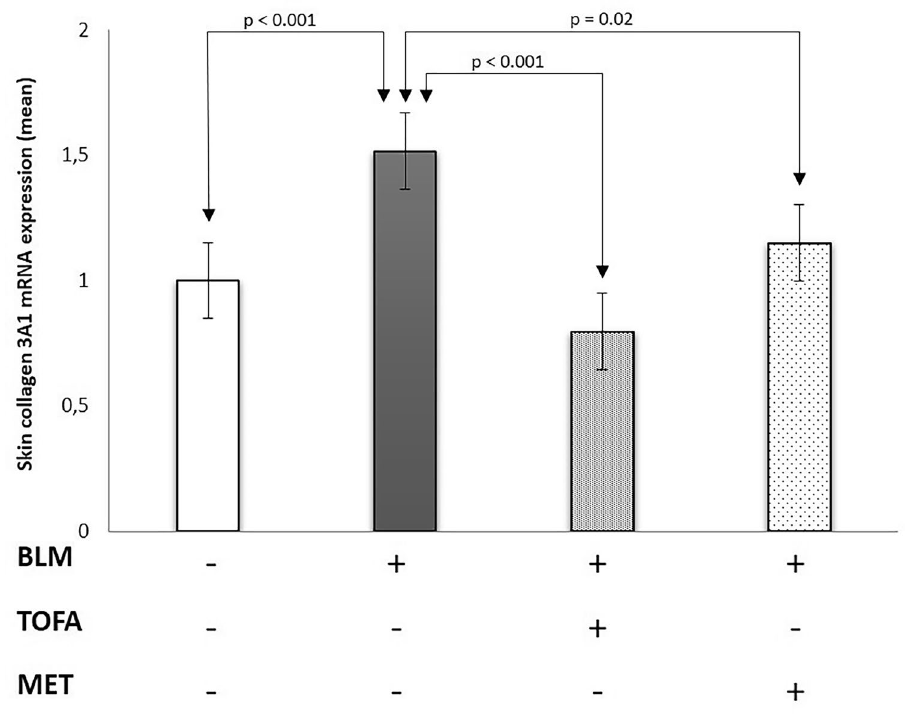
Figure 3. Skin collagen 3A1 messenger RNA expression in the study